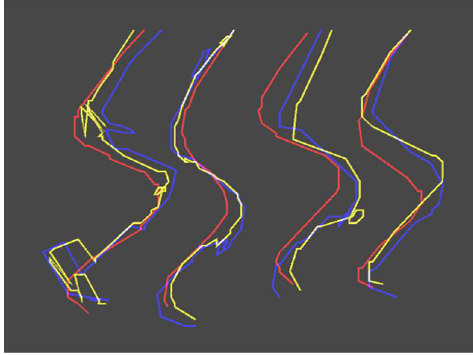
Fig. 26 No warning vs warning; order of experiment: s,r,o